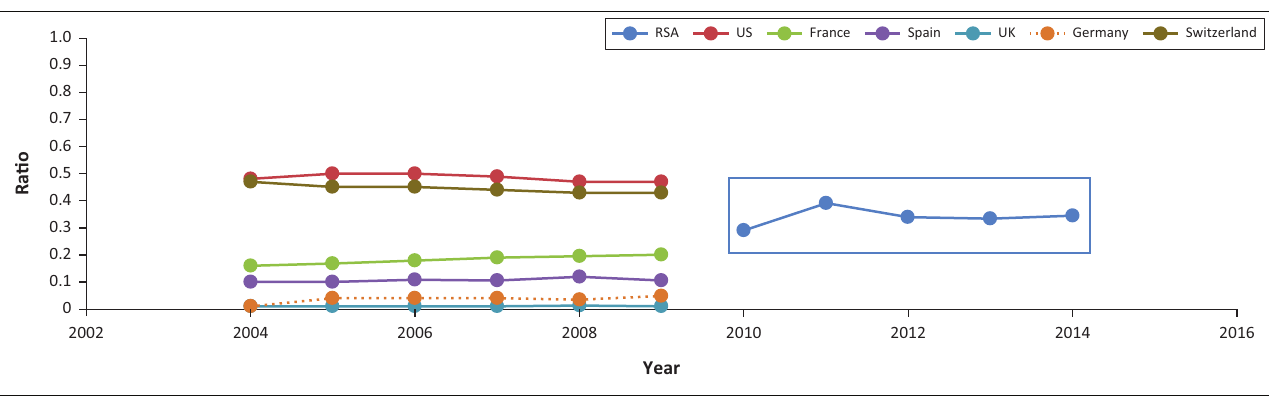
FIGURE 3: Road expenditure to gross domestic product ratio for selected countries.